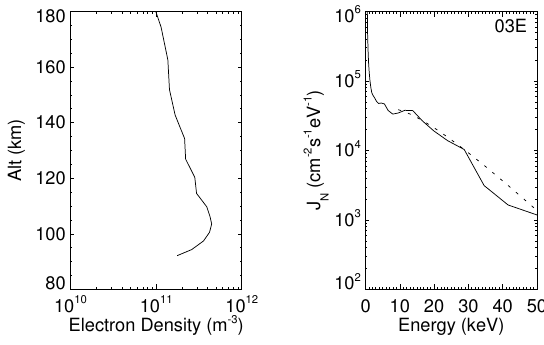
Fig. 10. The same as Fig. 7 but for events 03D and 03E.